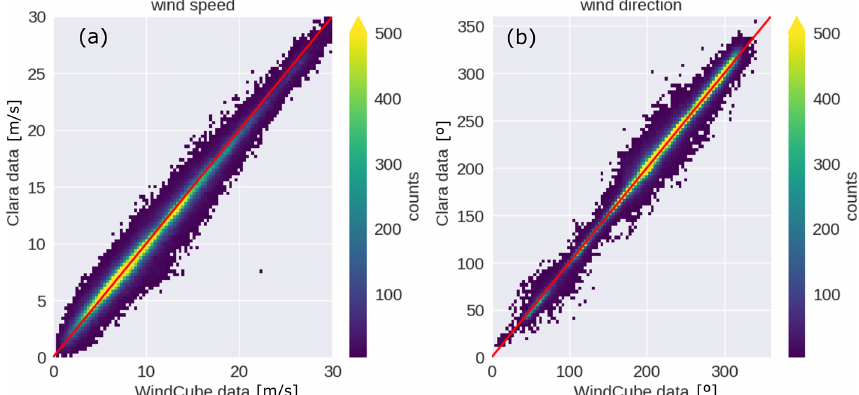
Figure 11. Two-dimensional histograms from the data pair WindCube–CLARA for wind speed (panel a ) and wind direction (panel b ); the red line indicates the 1 to 1 line.